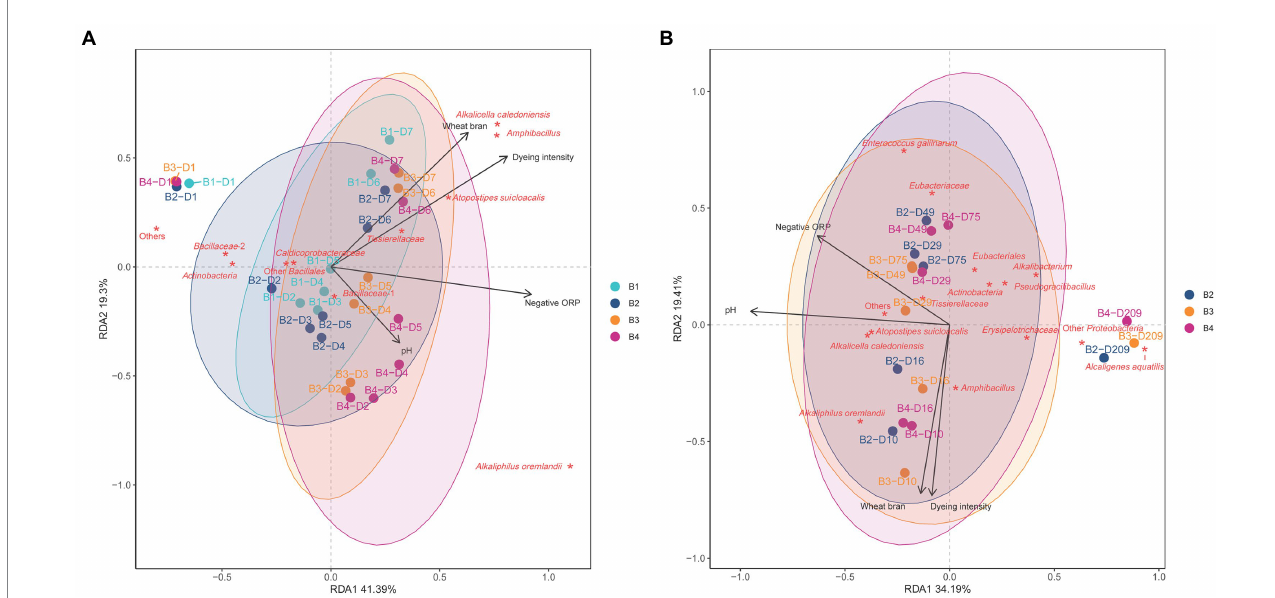
FIGURE 4 Redundancy analysis (RDA) of indigo fermentations during days 1–7 (A) and days 10–209 (B) following different initial treatments of sukumo . B1: batch 1 ( sukumo treated with 60 ° C tap water); B2: batch 2 ( sukumo treated with 25 ° C tap water [control]); B3: batch 3 ( sukumo treated with 25 ° C wood ash extract); B4: batch 4 ( sukumo treated with 60 ° C wood ash extract). The labels for samples indicate the batch number and the number of days of fermentation (B, batch; D, day). Red asterisks represent the core microbiota. Black arrows indicate different environmental factor. Wheat bran was considered an environmental factor given that it would be consumed within 1 month. Percentages on the axes represent the eigenvalues of principal components. (A) Bacillaceae -1 contains Sutcliffiella cohnii , Alkalihalobacillus macyae , Mesobacillus fermenti , and Bacillus dakarensis ; Bacillaceae -2 contain Oceanobacillus , Sinibacillus , and Pseudogracilibacillus ; Other Bacillales contains Paenibacillus and Salinicoccus kunmingensis . (B) Eubacteriaceae : Rhabdanaerobium thermarum (92.6%); Eubacteriales : Clostridium septicum